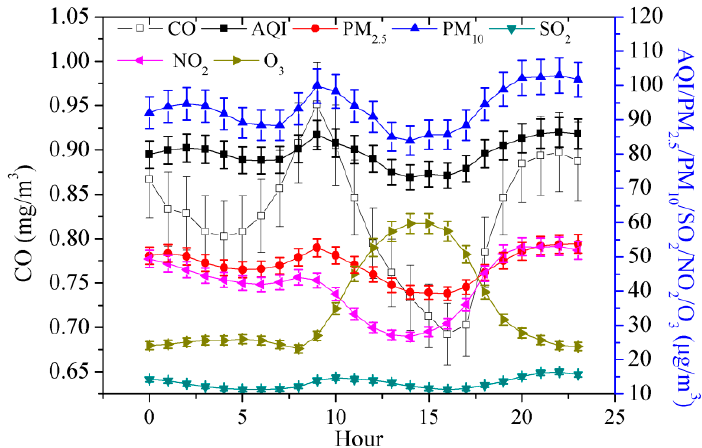
Figure 5. Average hourly variations in air quality in Jinan City. Table 7. Correlations between air quality and meteorological elements.